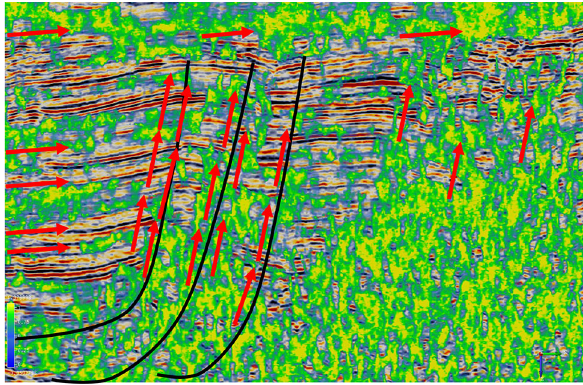
Fig. 11 Seismic chimneys analysis on inline 5282